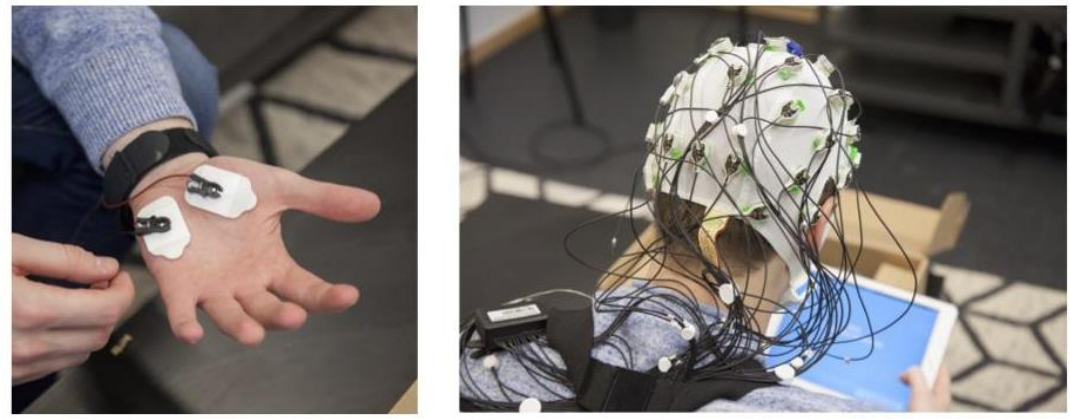
Figure 5. EDA Sensors ( left ) and electroencephalography (EEG) Headset ( Right ).